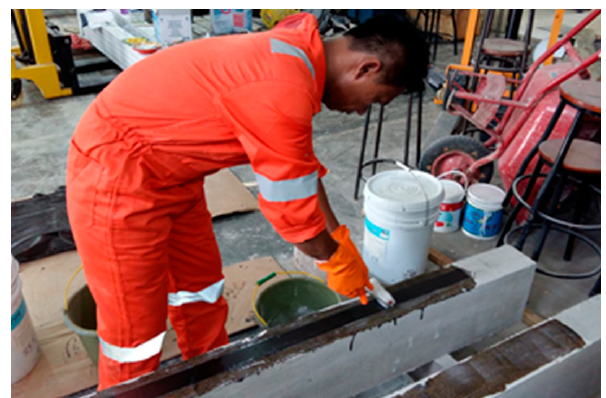
Figure 2. Installing the CFRP plate at the bottom of the beam.